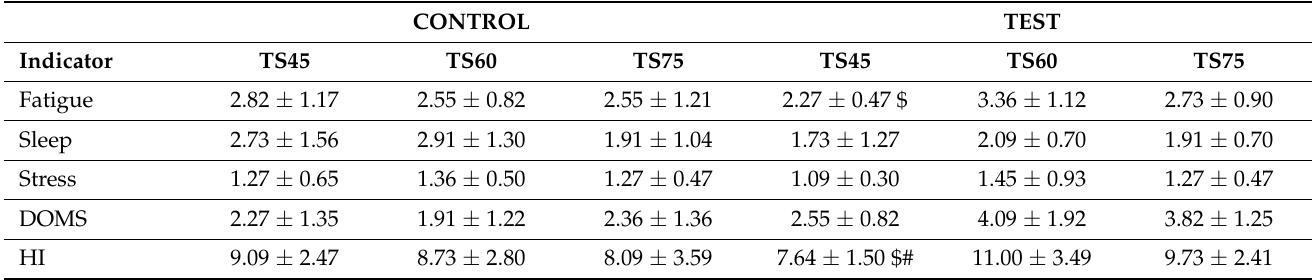
Table 3. Values of Hooper questionnaire for CONTROL and TEST during the three